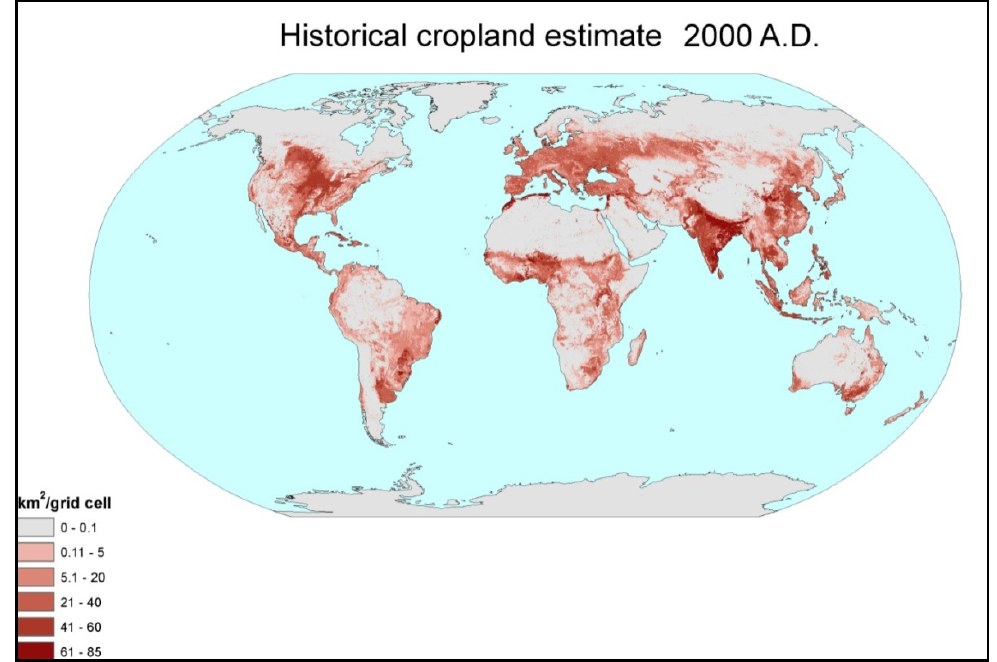
Figure 3. Global irrigated cropland area map by Goldewijk et al . [42]. This includes irrigated and rainfed areas of the world as well as permanent crops. Total area of croplands is 1.47 billion hectares. The product is derived using national agricultural census data and remote sensing land use. The output is given in nominal 5-min (0.083333 decimal degrees) resolution.